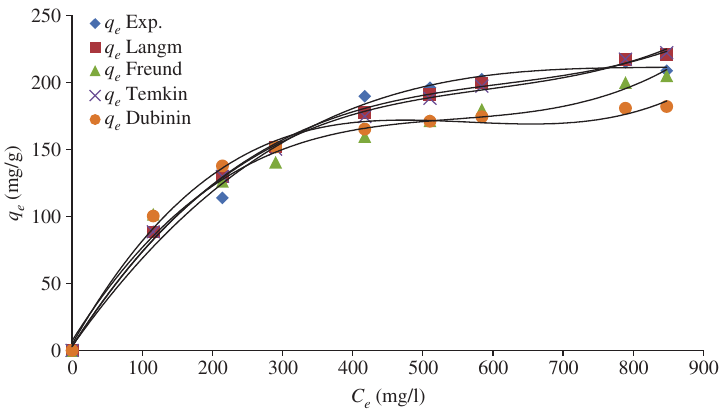
Figure 5: Comparison of two-parameter isotherm models with experimental data of Pb(II) onto S. sesban L. at 30 ° C.